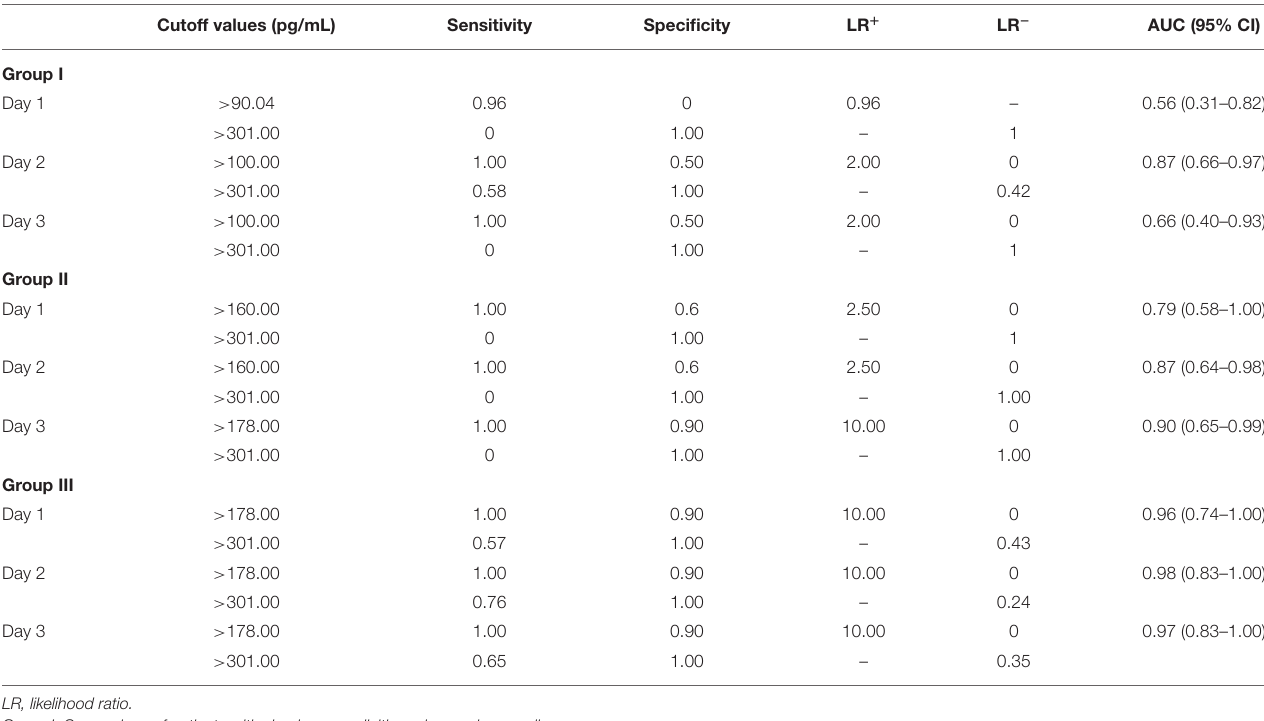
TABLE 3 | Sensitivity, specificity, LR + , and LR − at the two cutoff values of sCD40L to rule out and rule in simple appendicitis, gangrenous appendicitis, and ruptured appendicitis in children. Cutoff values (pg/mL)